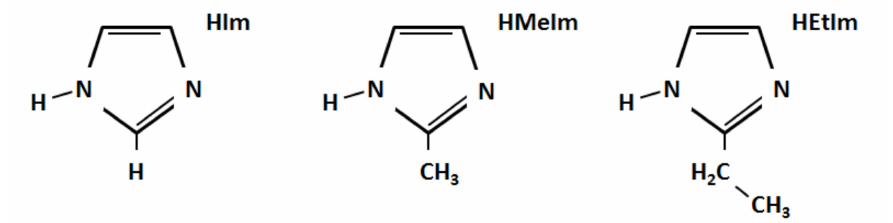
Figure 1. The ligands 2-imidazolate (HIm), 2-methylimidazolate (HMeIm) and 2-ethylimida- zolate